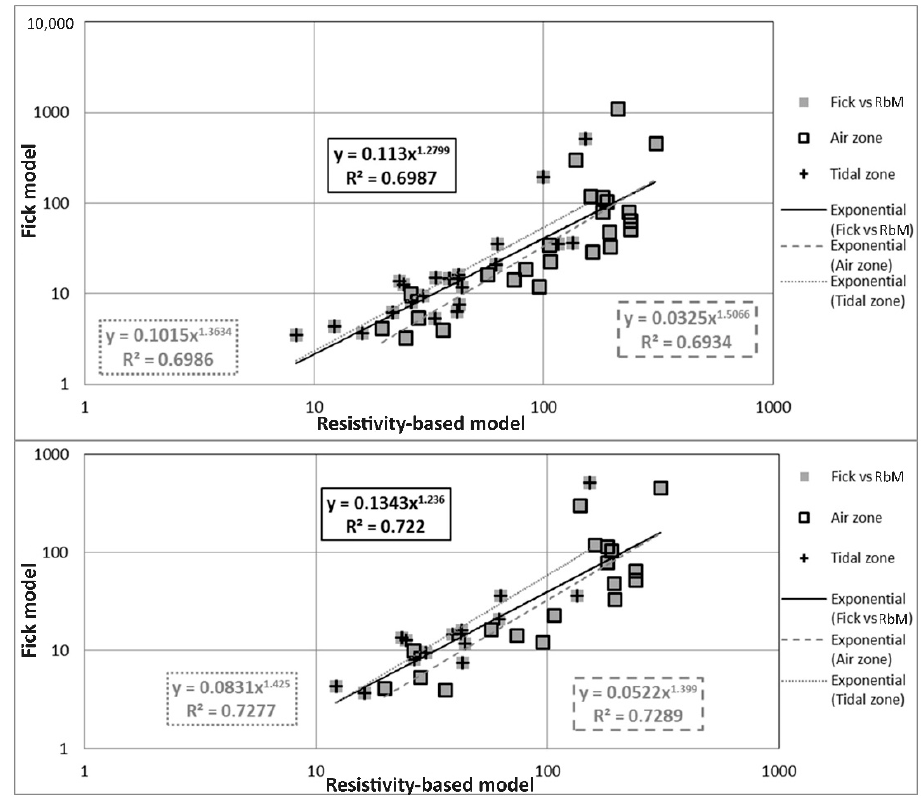
Figure 11. Fick’s model vs. Resistivity-based model (RbM) and exhibition zones, with correction of outliers (up) and without outliers (down).